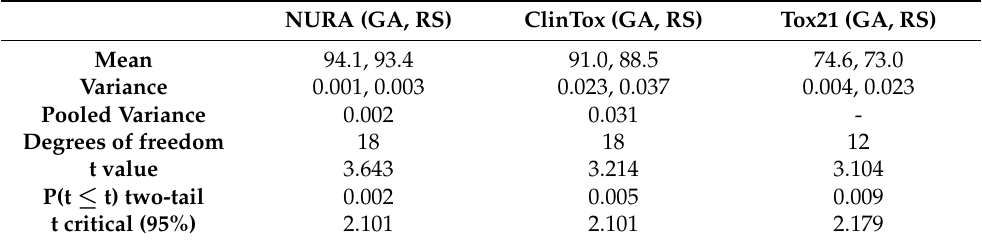
Table A1. Two-tailed t-test with a hypothesized zero mean difference for the three datasets consider- ing the best result among 10 replicas between genetic algorithms (GA) and random search (RS) on 3-fold cross validation. Variances were assumed unequal only for Tox21 ( p -value of F test 0.007).